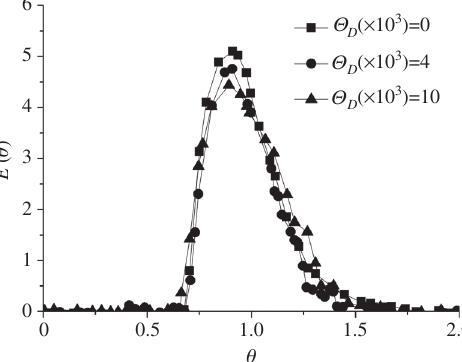
Figure 10 Dimensionless E( θ ) curves of mineral oil-seawater mul- tiphase flow for different dimensionless dispersant injection